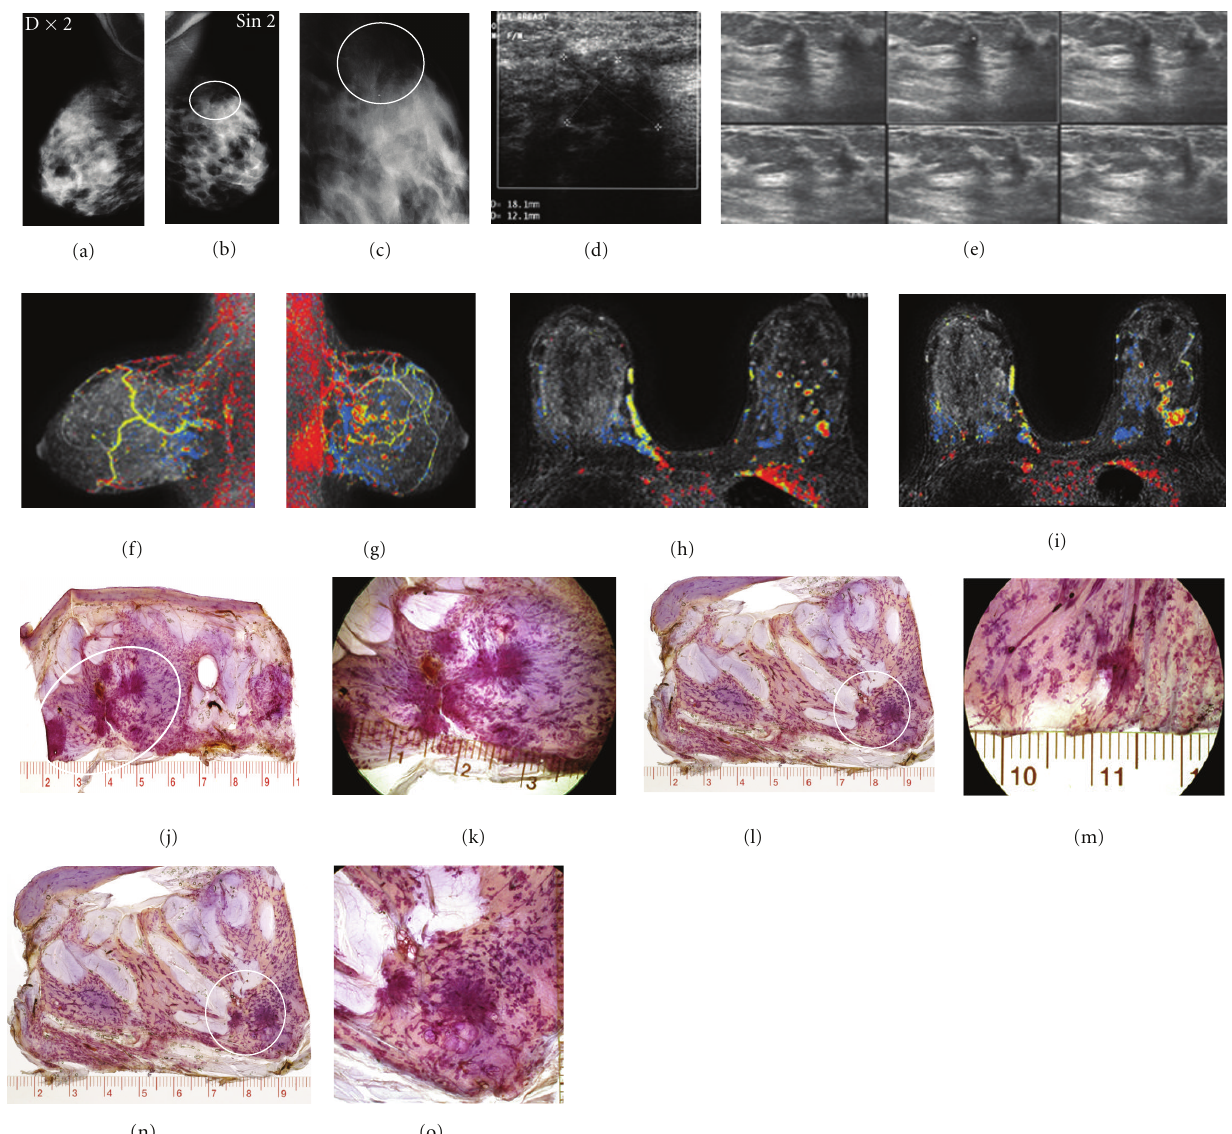
Figure 4: Right (a) and left (b) mammograms, mediolateral oblique projections. Subtle architectural distortion and parenchymal contour change are confirmed on the microfocus mammographic image (c) of the left breast (encircled). Hand-held ultrasound (d) and